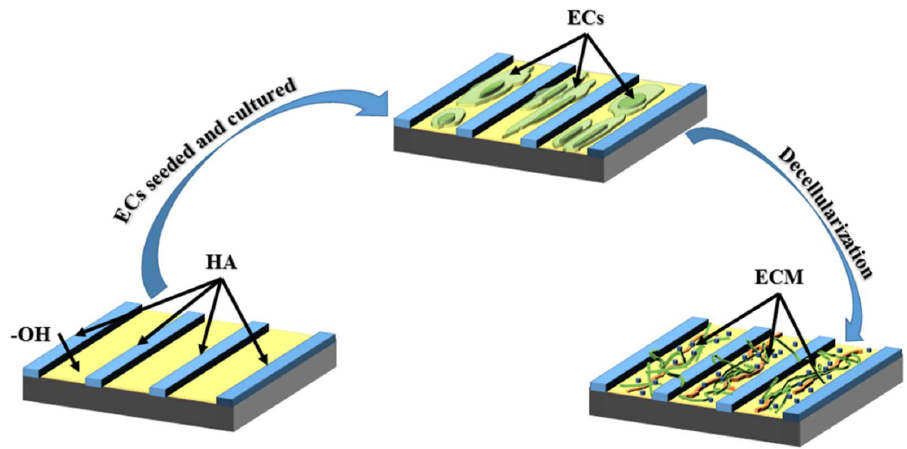
Figure 3. The scheme of preparing hyaluronic acid (HA)-patterned extracellular matrix (ECM): To obtain better biocompatibility, Li et al. controlled the vascular endothelial cells (EC) via preparing hyaluronic acid micro-pattern on materials surfaces to simulate the in vivo blood flow condition, and the extracellular matrix secreted by the patterned EC also showed similar property with the EC in vivo; Further investigation proved that the ECM left on the HA micro-pattern after decellularization had better biocompatibility compared to the ECM secreted by those EC on non-patterned surface [23]. Laser micro-patterning has been developed rapidly because of its rapid and precise processing [25]. Liang et al. prepared vascular smooth muscle cell (VSMC) micro/nano biomimetic surface patterns on 316L stainless steel (316L SS) by using femtosecond laser (FSL), processing to achieve the purpose of rapid endothelialization [26]. Cell and animal experiments show that it can promote the